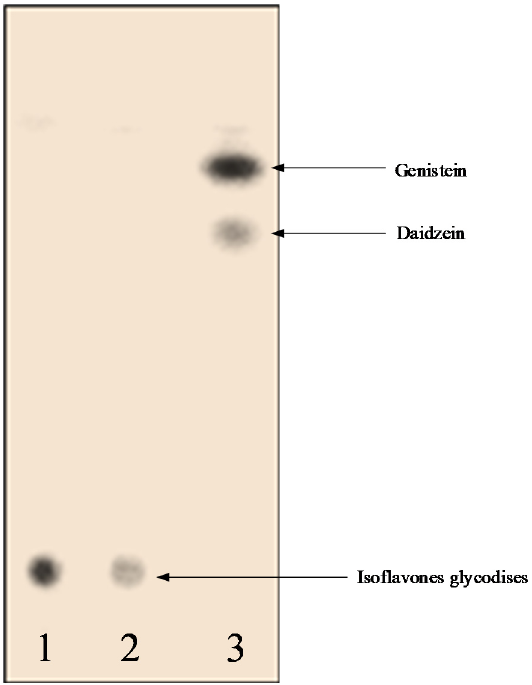
Figure 5. TLC results of fermentation of soybean residual extract using P. citrinium at 30 °C during (1) 2 h, (2) 48 h, and (3) 72 h. Table 1. Effect of hydrolysis time of soybean residual extract on isoflavon glucosides and aglycones formation by P. citrinium at 30 °C.